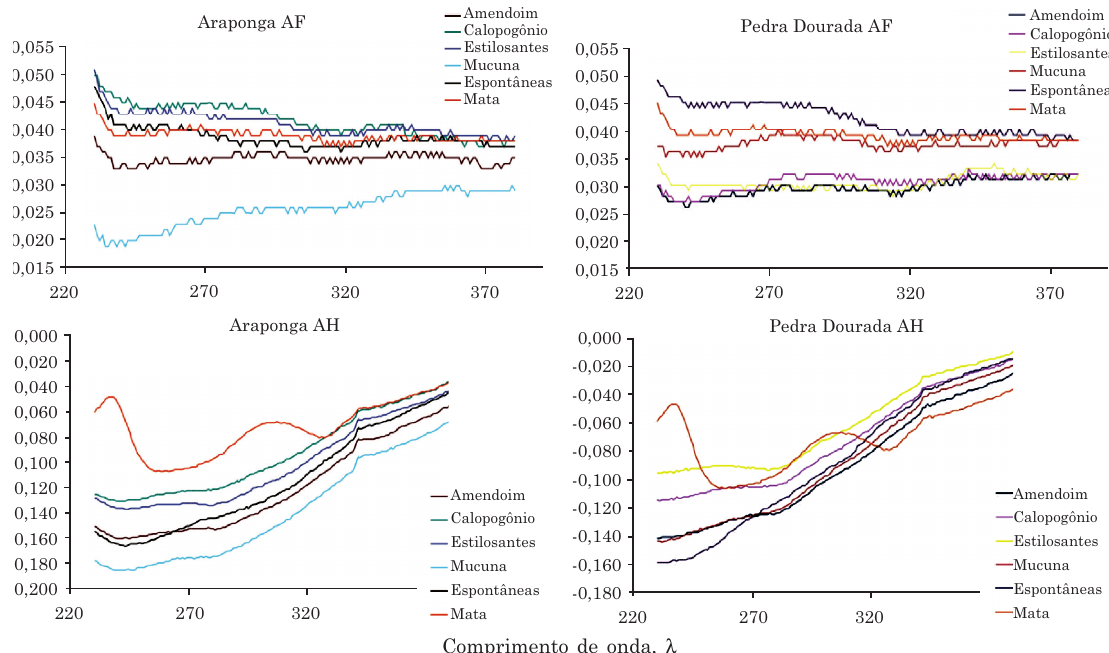
Figura 2. Espectros diferenciais na região do ultravioleta de ácidos fúlvicos e húmicos isolados de solos sob adubação verde e espécies espontâneas, em duas propriedades com diferentes condições edafoclimáticas.